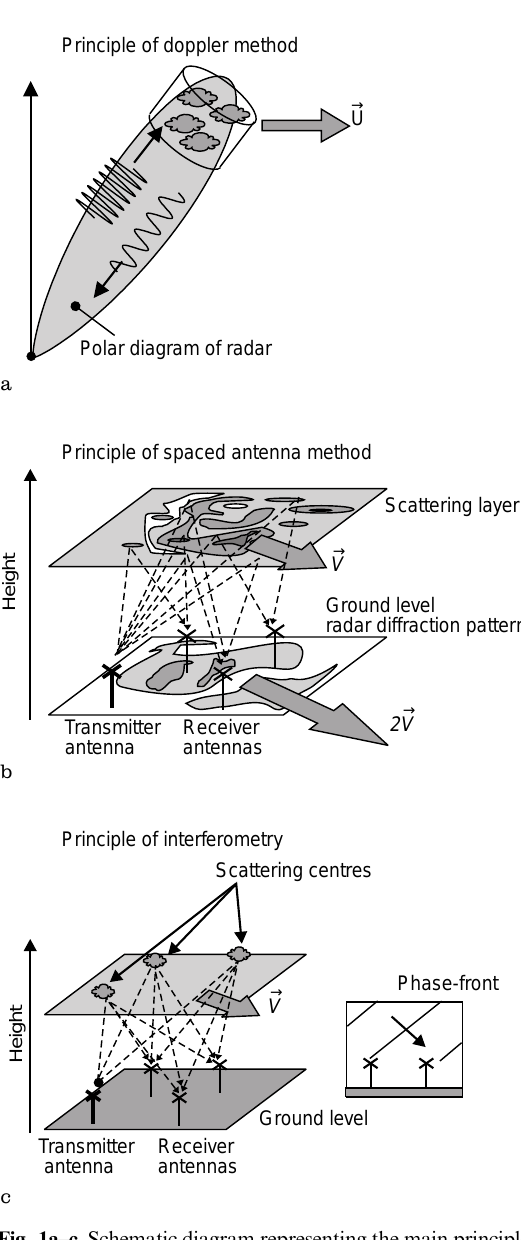
Fig. 1a–c. Schematic diagram representing the main principles applied in radar techniques. a demonstrates the Doppler method, b shows the spaced-antenna method and c shows the interferometric principle. In a, the Doppler shift of the returning radiation relative to that transmitted is indicated, and this shift is the basis of the method. In b, the scattering distribution over the sky at one altitude is shown, together with the di(cid:128)raction pattern on the ground. Note that the broken lines represent just a few of the many ‘‘ray paths’’ which can exist; the radiation propagating along these paths eventually interferes at the ground to give the resultant di(cid:128)raction pattern. In c, the e(cid:128)ective ray paths associated with just a few scatterers are shown. The inset to the right shows incoming phase fronts from a single scatterer in two dimensions, illustrating that a single phase front arrives at di(cid:128)erent antennas at di(cid:128)erent times. The delay between phase fronts arriving at di(cid:128)erent antennas is used to determine the original location of